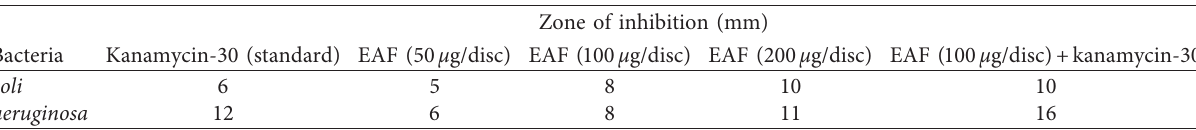
Table 3: Diameter of zone of inhibition (mm) of EAF against drug-resistant